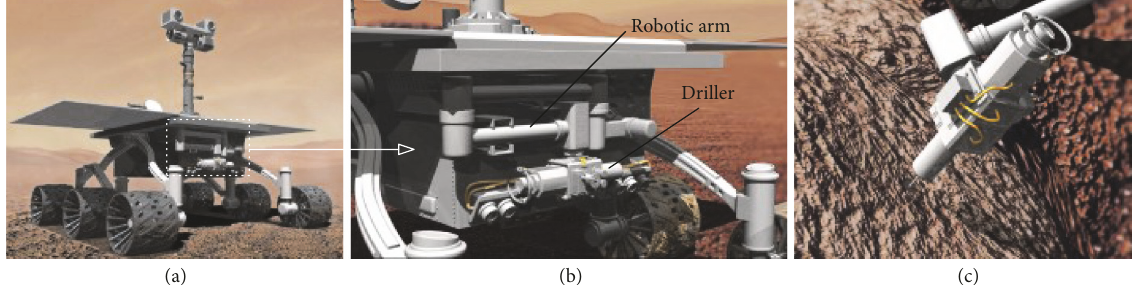
Figure 1: The description of rock sampling and detection mission on the extraterrestrial objects. (a) Exploration rover; (b) ultrasonic drill on the robotic arm. (c) Drilling and sampling work.